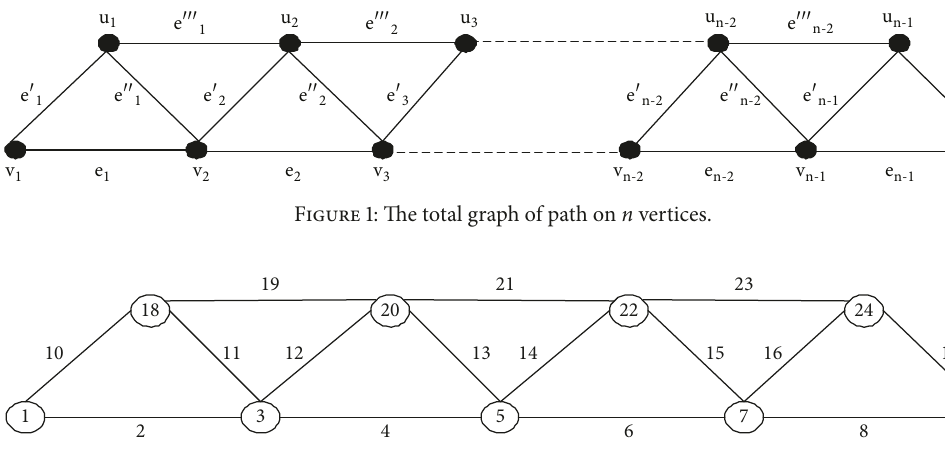
Figure 2: The super mean labeling for total graph of path on 5 vertices, 𝑇(𝑃 5 ) .